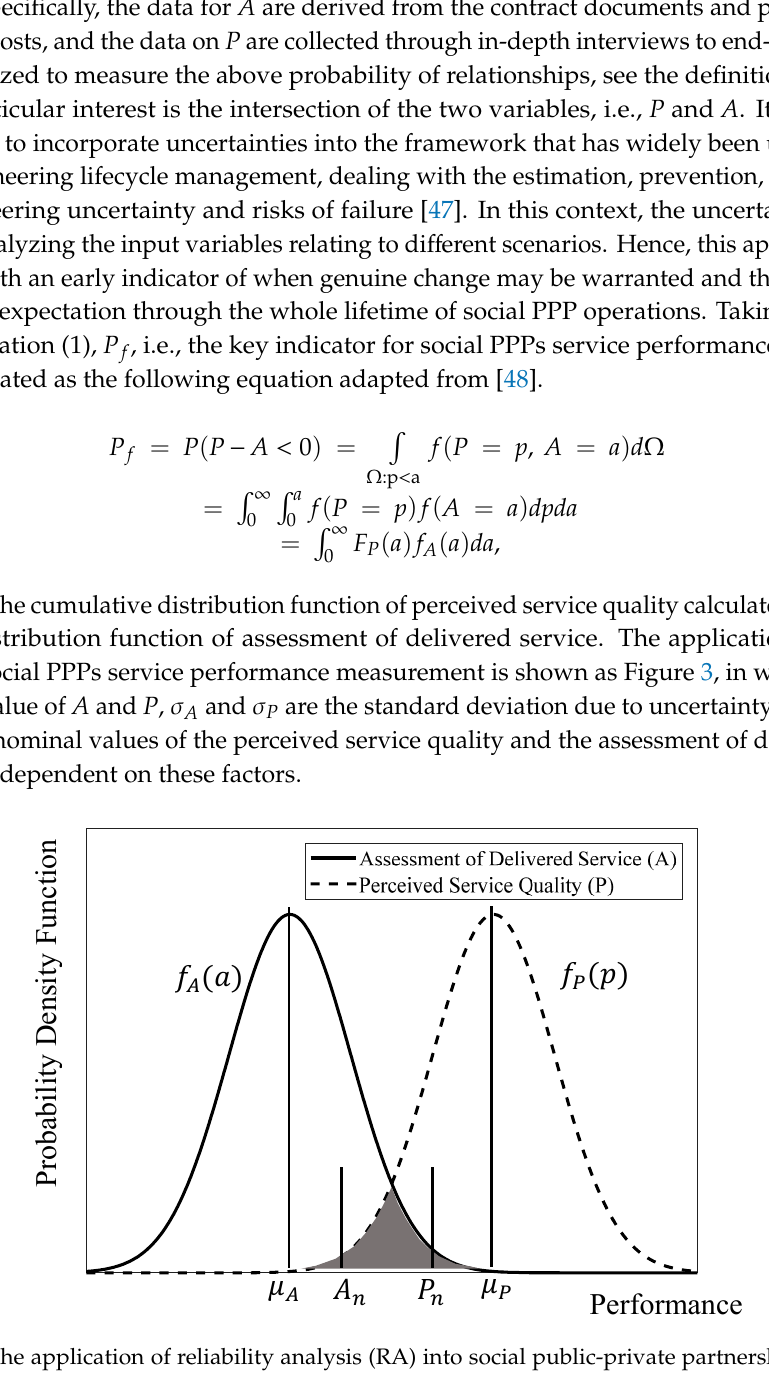
Figure 3. The application of reliability analysis (RA) into social public-private partnerships’ (PPPs) performance evaluation.